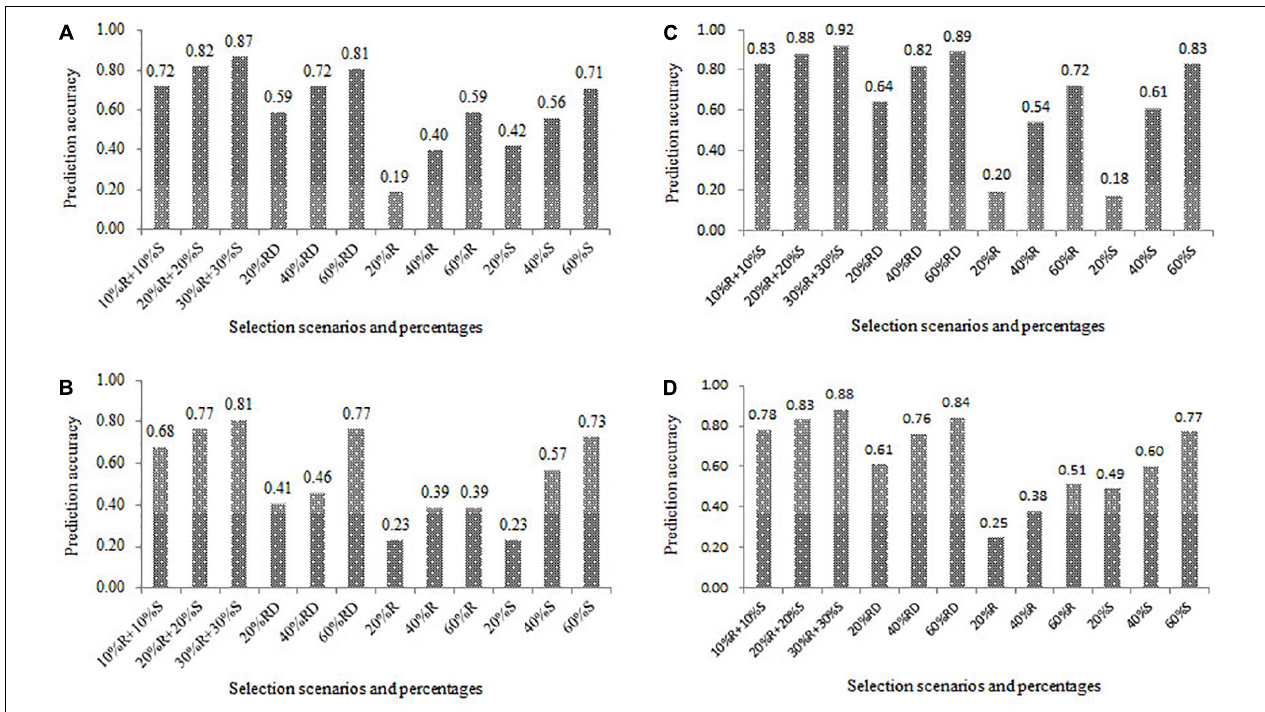
FIGURE 6 | Genomic prediction accuracies estimated in the 12 combinations between the four scenarios and the three percentage levels of the training set (20, 40, and 60%) in the four populations of (A) DTMA association mapping panel, (B) Pop1, (C) Pop2, and (D) Pop3. The scenario of R + S represents the selection from both resistant and susceptible tails, RD represents the random selection, R represents the selection from the resistant tail, S represents the selection from the susceptible